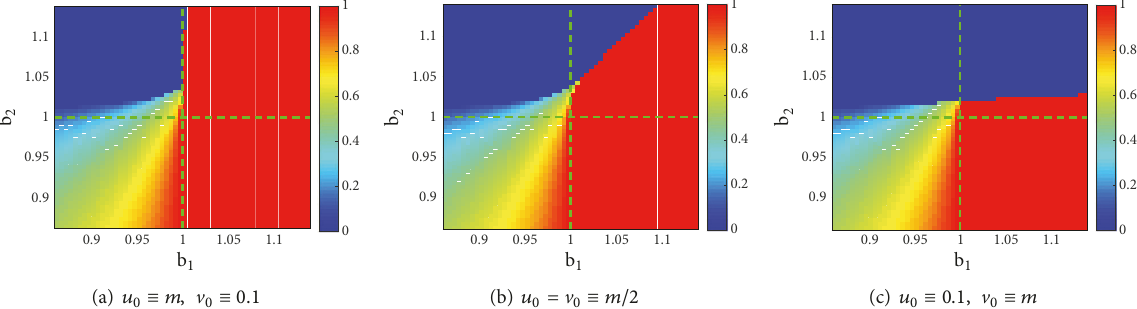
Figure 3: SDD 1 versusSDD 2 :in thesituation of Theorem 4, themass ratio ∫𝑢(𝑡)𝑑𝑥/ ∫(𝑢+ V )(𝑡)𝑑𝑥 of numericalsolutions is plotted at 𝑡 = 1000 with the parameters in (14). In the red and blue region SDD 1 and SDD 2 prevail, respectively. The SDD 1 is advantageous since it survives near 𝑏 = 𝑏 = 1 1 2